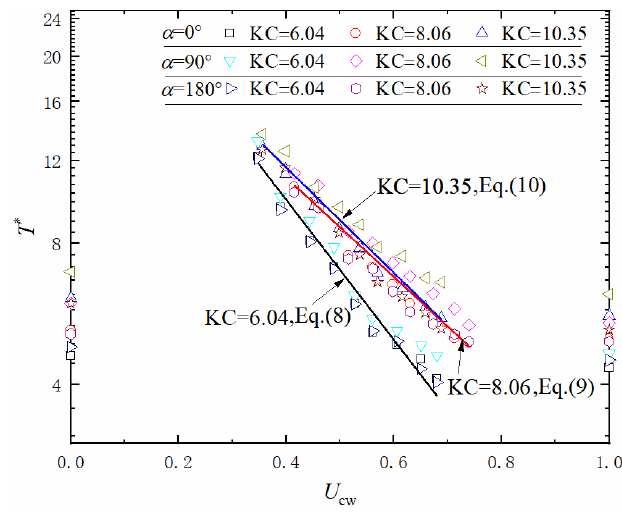
Figure 6. The relationships between T * and U cw and fitting results.